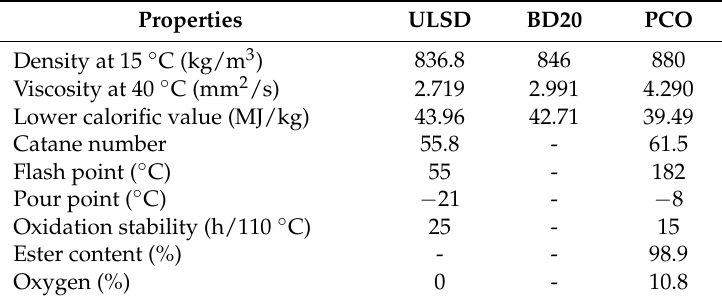
Table 2. Experimental and operating conditions.